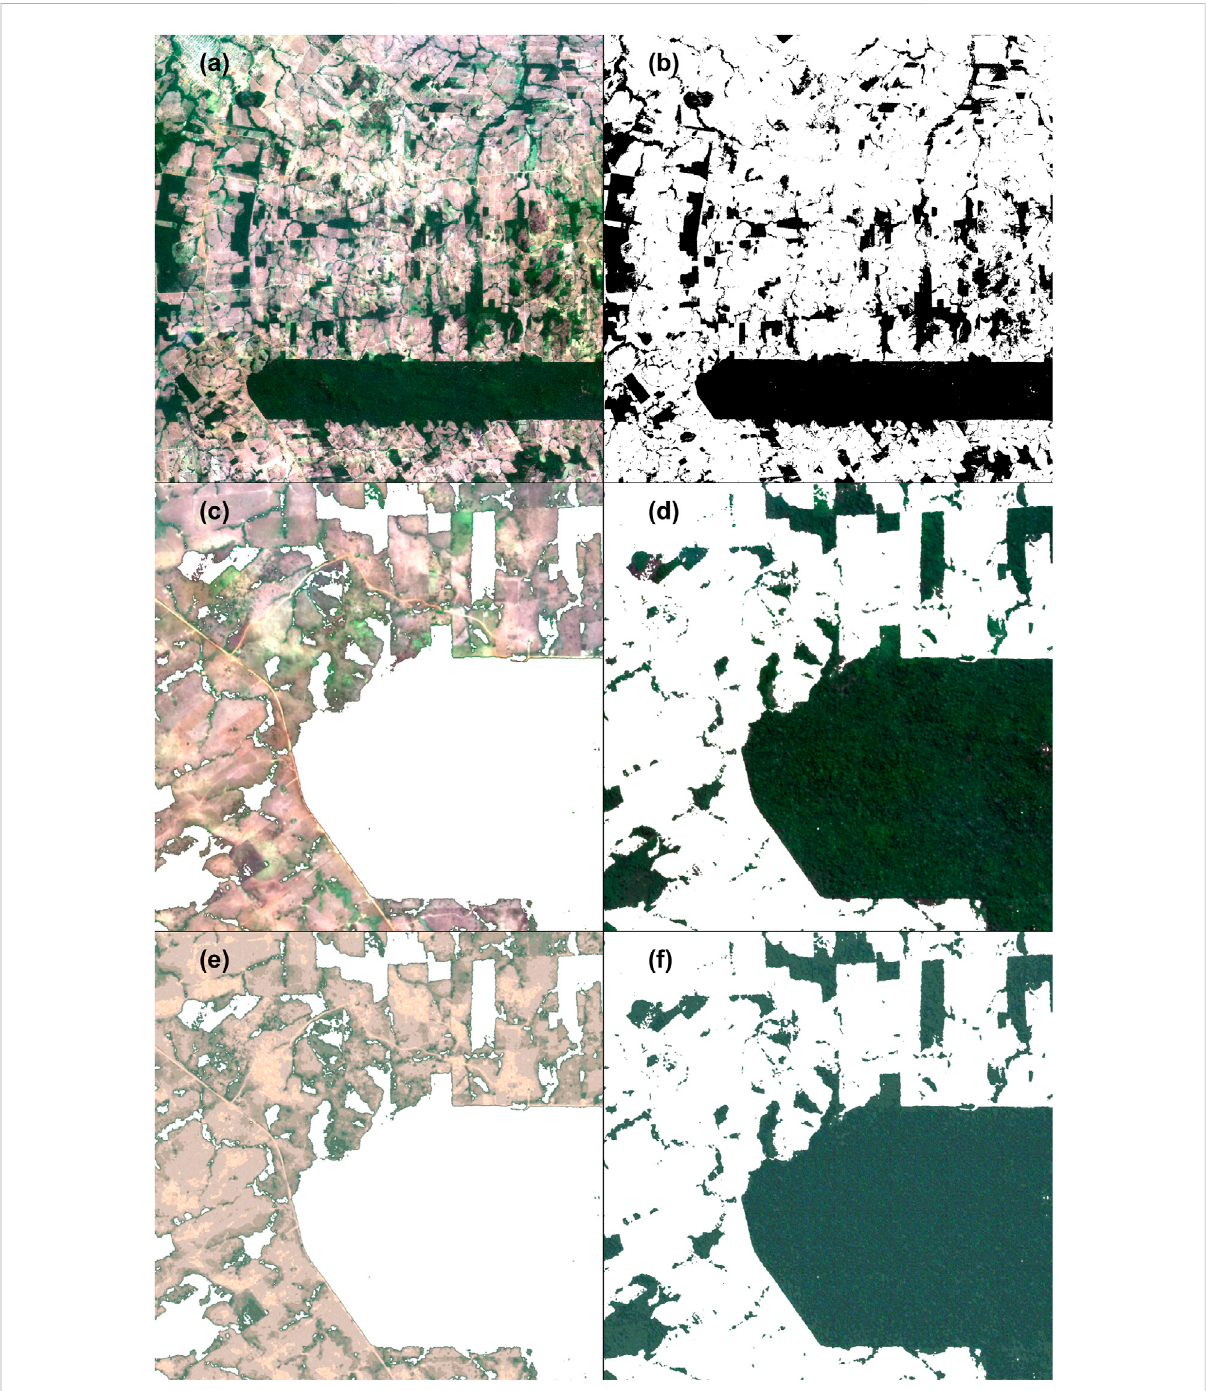
FIGURE 10 Example of self-segmentation of a Planet image using the k-textures model and k = 9 classes. Original Planet image (A) , for visualization only RGB bands are used. Forest mask produced with k-textures self-segmentation (B) where clusters 8 and 9 have been interpreted by the user to be forest and other cluster to represent other land used. Planet image with colors channels set to [255,255,255] for the pixels in the forest mask (C) . Planet image with colors channels set to [255,255,255] for the pixels outside the forest mask (D) . Simulated Planet image from the k-textures model with colors channels set to [255,255,255] for the pixels in the forest mask (E) and Simulated Planet image from the k-textures model with colors channels set to [255,255,255] for the pixels outside the forest mask (F)